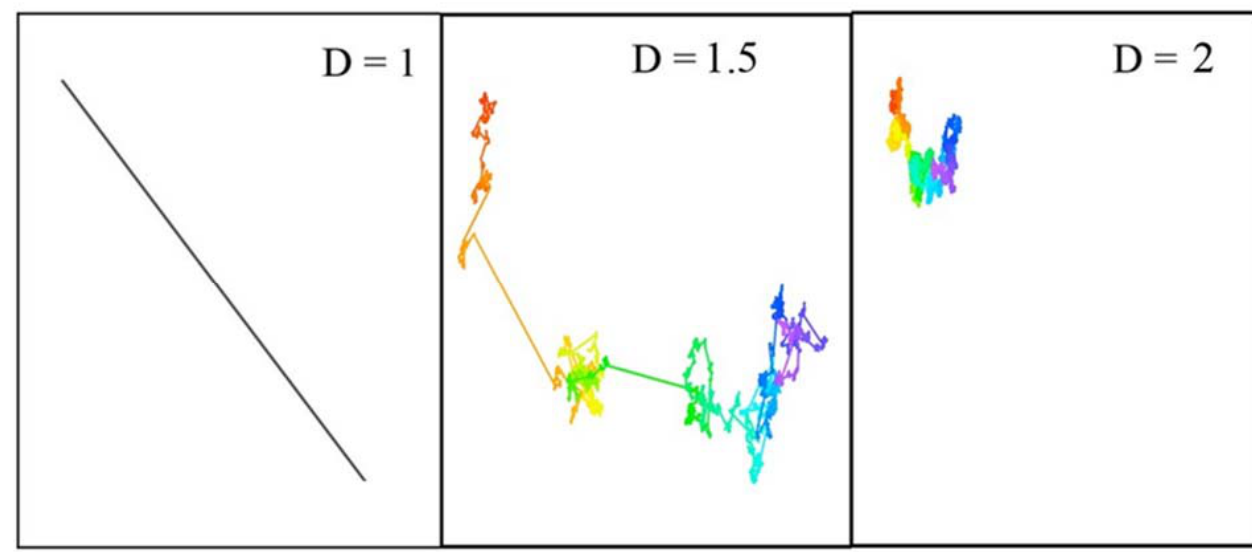
Figure 6. Fractal trajectories are adopted by foraging animals and for visual searches: The fractal trajectory ( middle ) is optimal for searches when compared to straight trajectories ( left ) and random trajectories ( right ). Figure by R. P. Taylor.